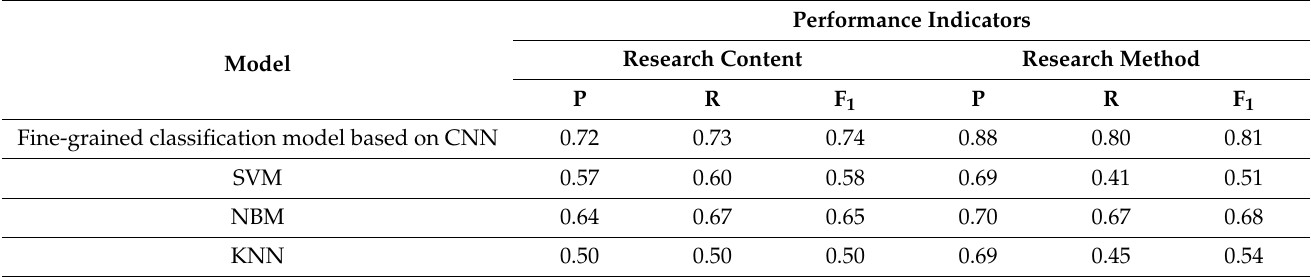
Table 9. Classification results of literature topics in data science and analytics using different models.